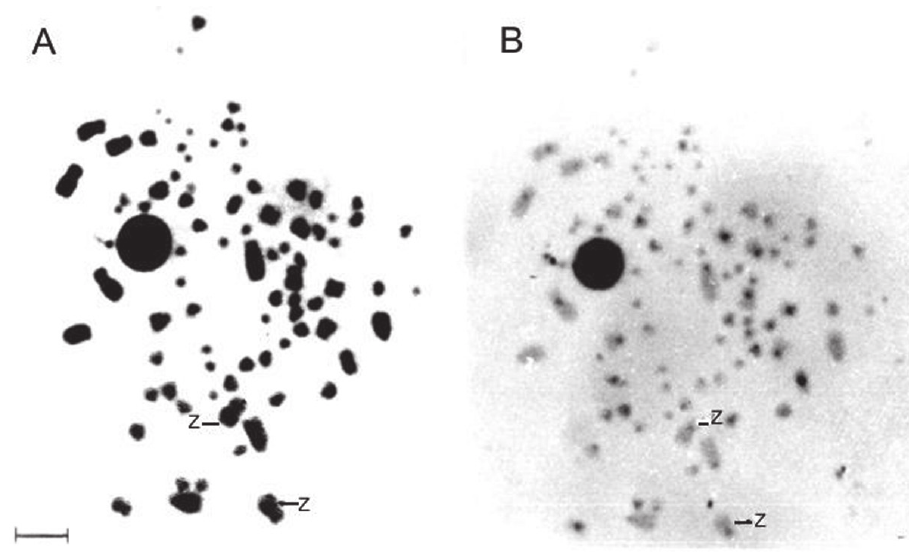
Figure 3. Routine Giemsa ( A ) and C-heterochromatin ( B ) sequential staining for a male Nyctibius griseus . The arrows indicate ZZ sex chromosomes. Bar = 5